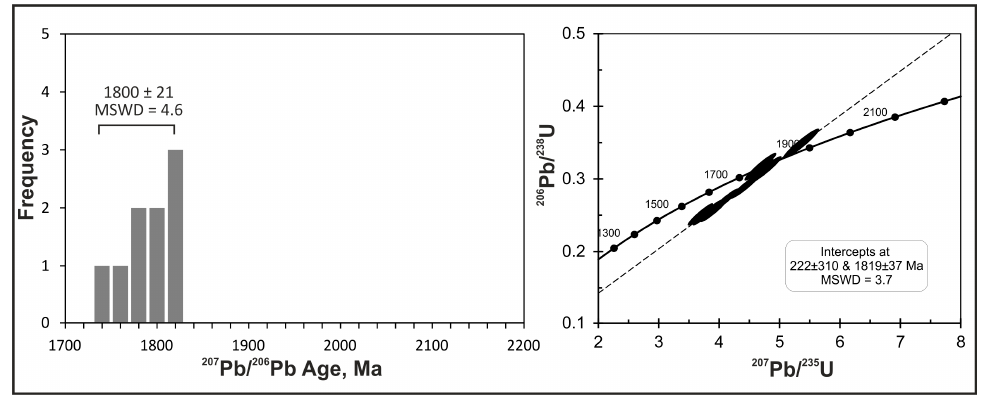
Figure 6. Frequency distribution diagrams for 207 Pb/ 206 Pb ages and Wetherill concordia diagrams for Type 3 uraninite (sample #24041346).